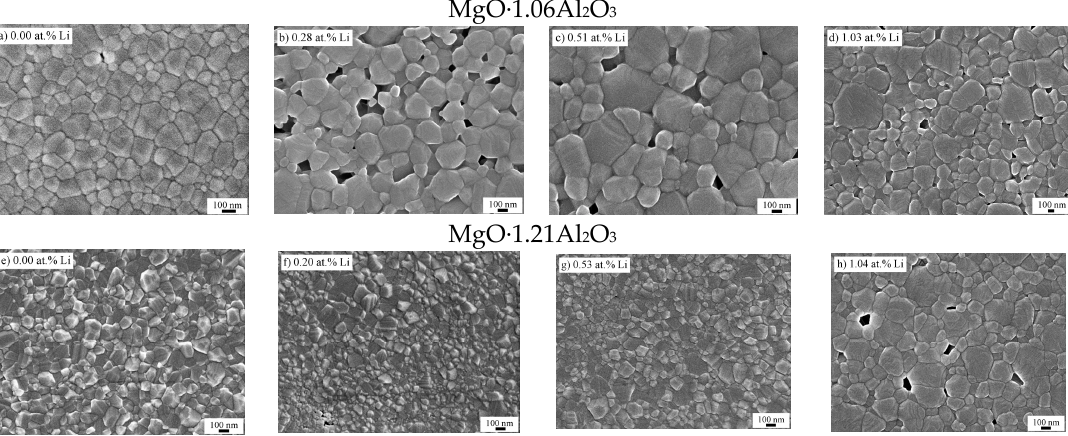
Figure 3. SEM micrographs of MgO·1.06Al 2 O 3 and MgO·1.21Al 2 O 3 SPS-processed samples. (a)–(h).